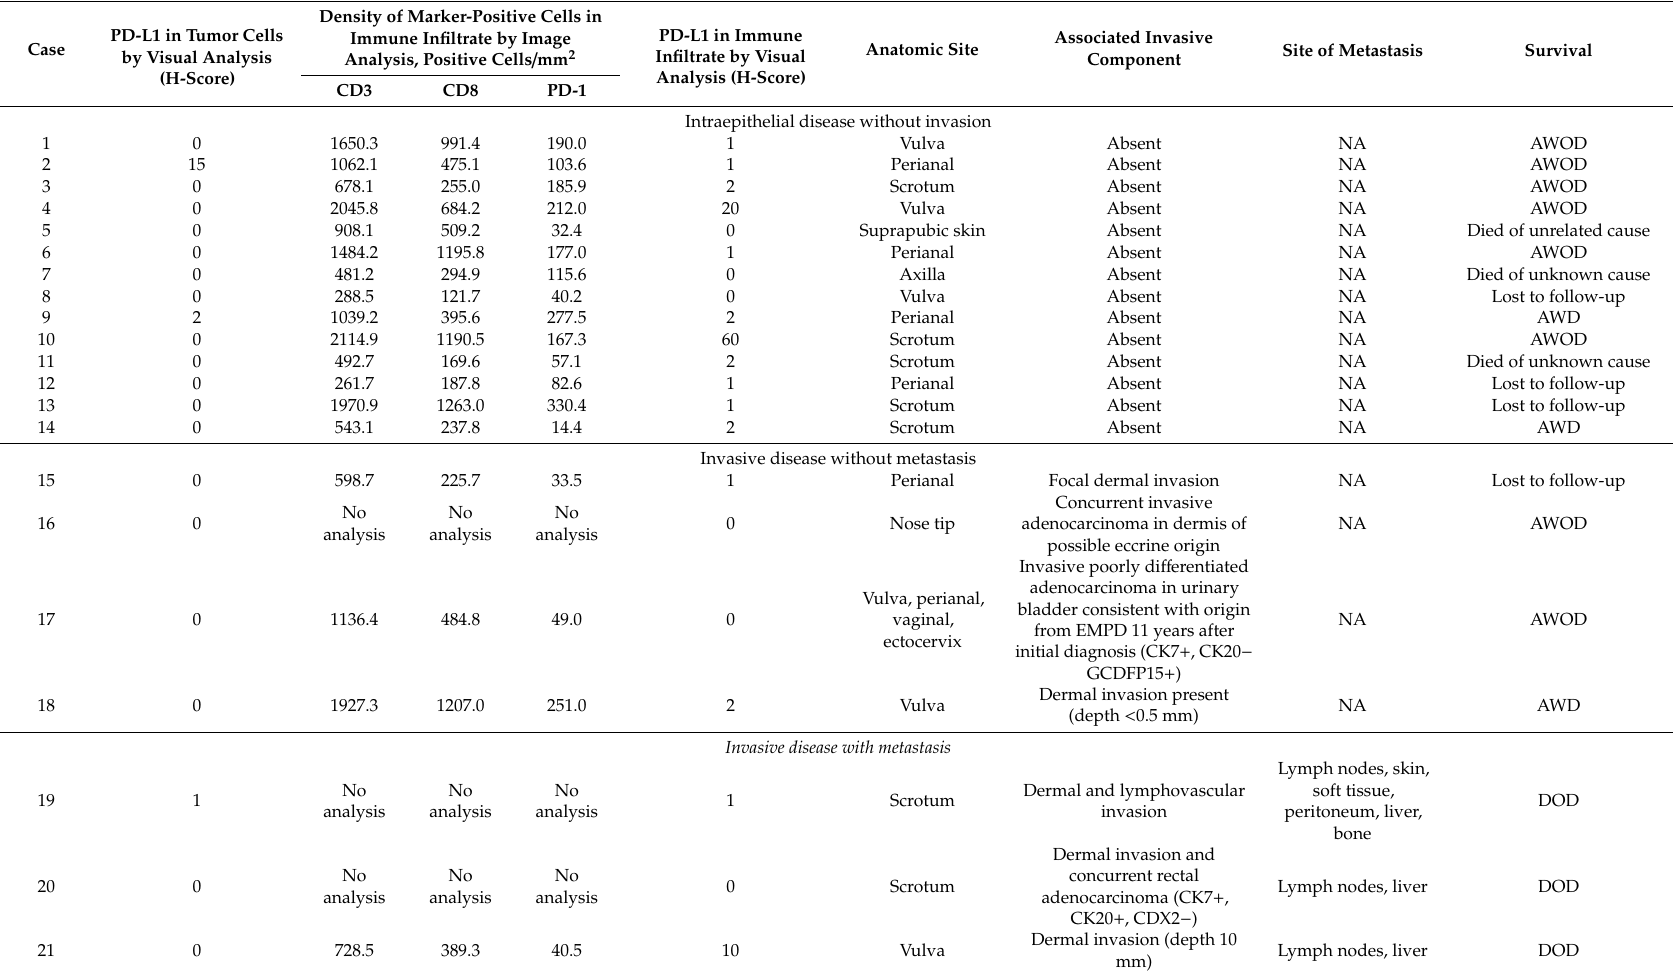
Table 2. Clinical-pathologic findings by patient in patients with extramammary Paget disease (EMPD).